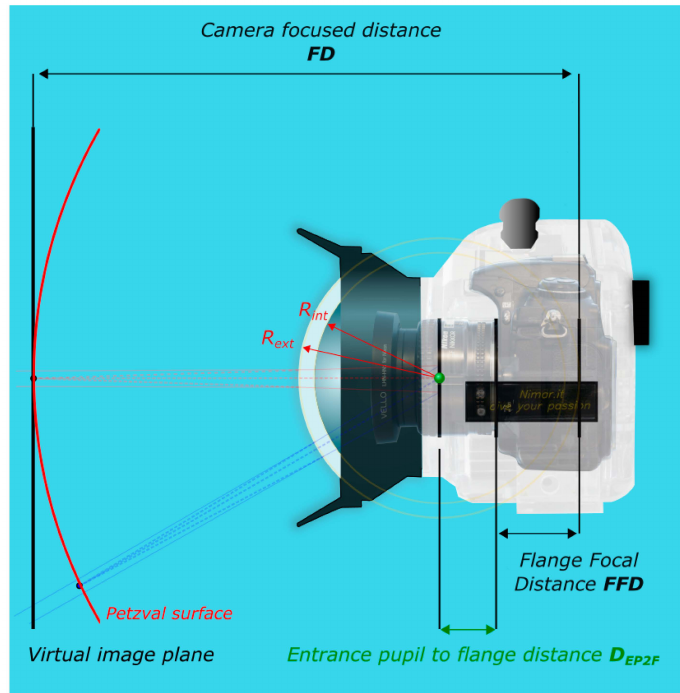
Figure 6. Main photographic elements in the image formation through a dome